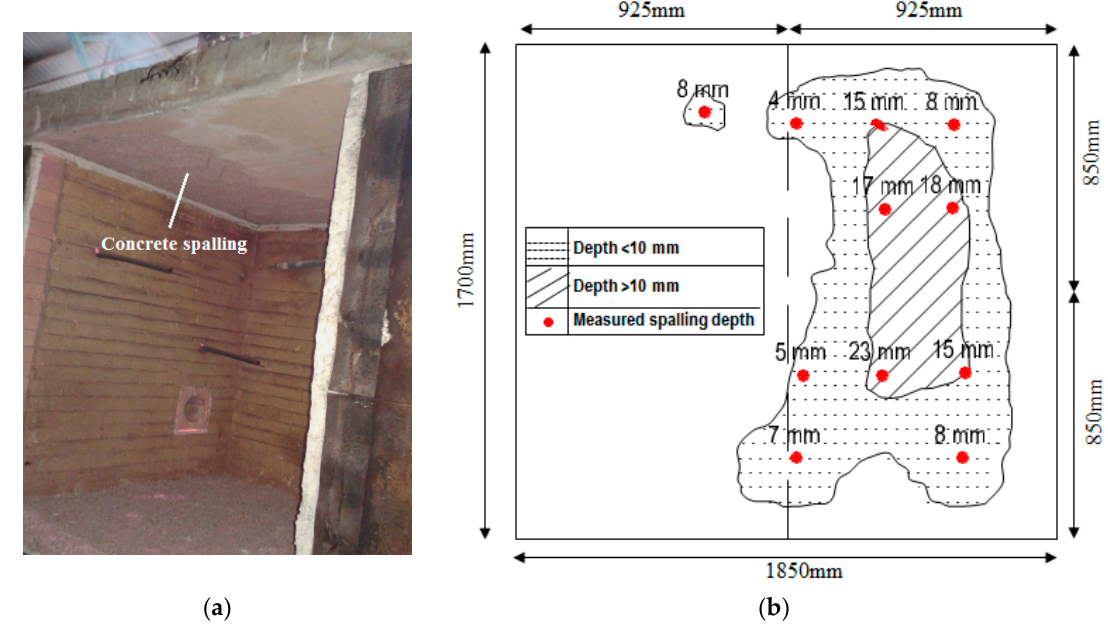
Figure 5. Concrete spalling: ( a ) visual appearance and ( b ) coverage area.